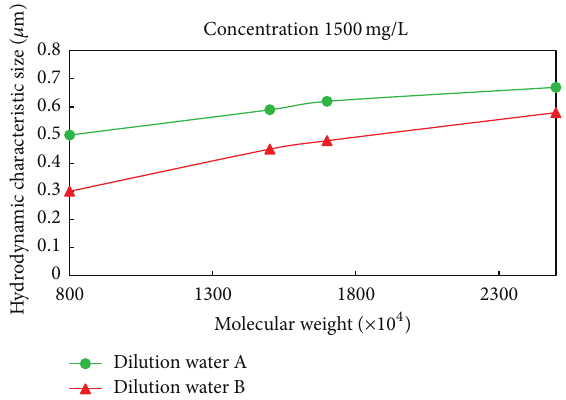
Figure 4: The hydrodynamic characteristic size increased as molec- ular weight